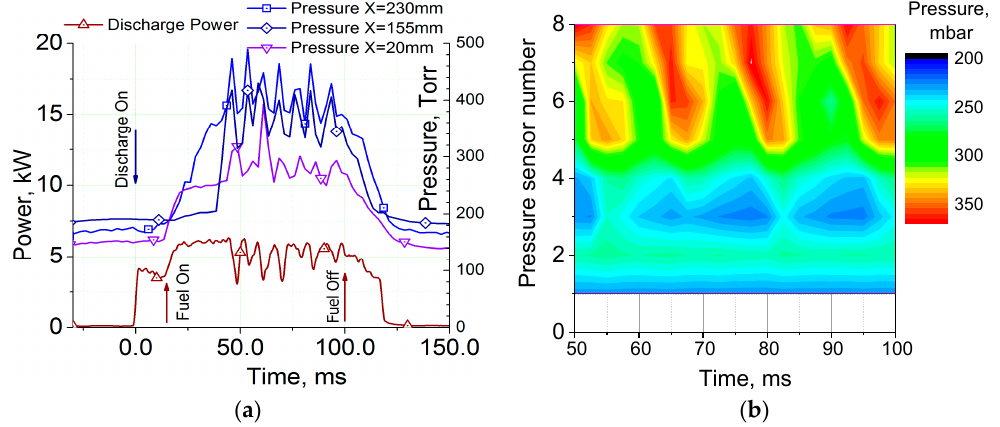
Figure 27. ( a ) Discharge power and wall pressure traces during combustion instability, ṁ C2H4 = 5.9 g/s; low-pass cutoff filter is applied; ( b ) 2D dynamics of pressure distribution, time is counted from plasma on.